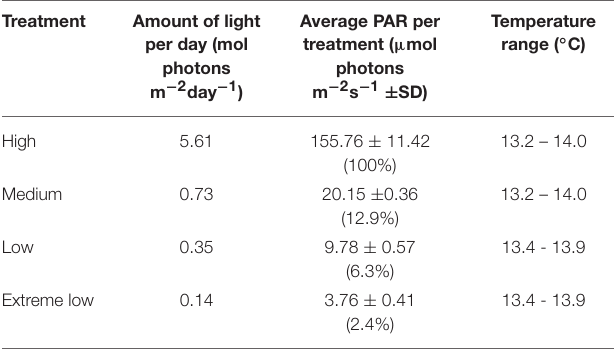
TABLE 1 | Total amount of light recorded by Odyssey PAR logger placed within tanks (calibrated with a LI-COR, Li-250A light meter) and temperature range logged for each treatment